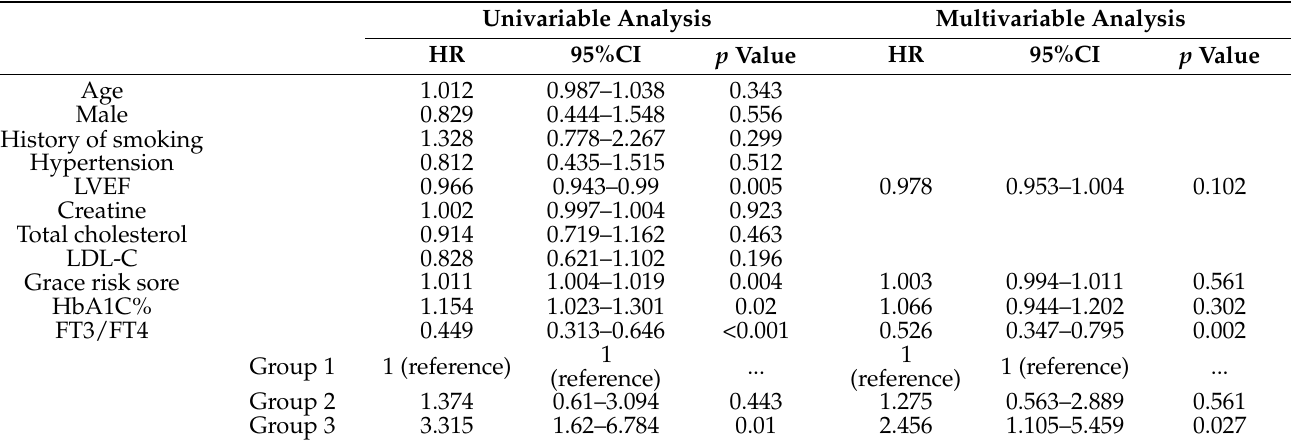
Table 4. Cox regression analysis of factors associated with major adverse cardiac events.